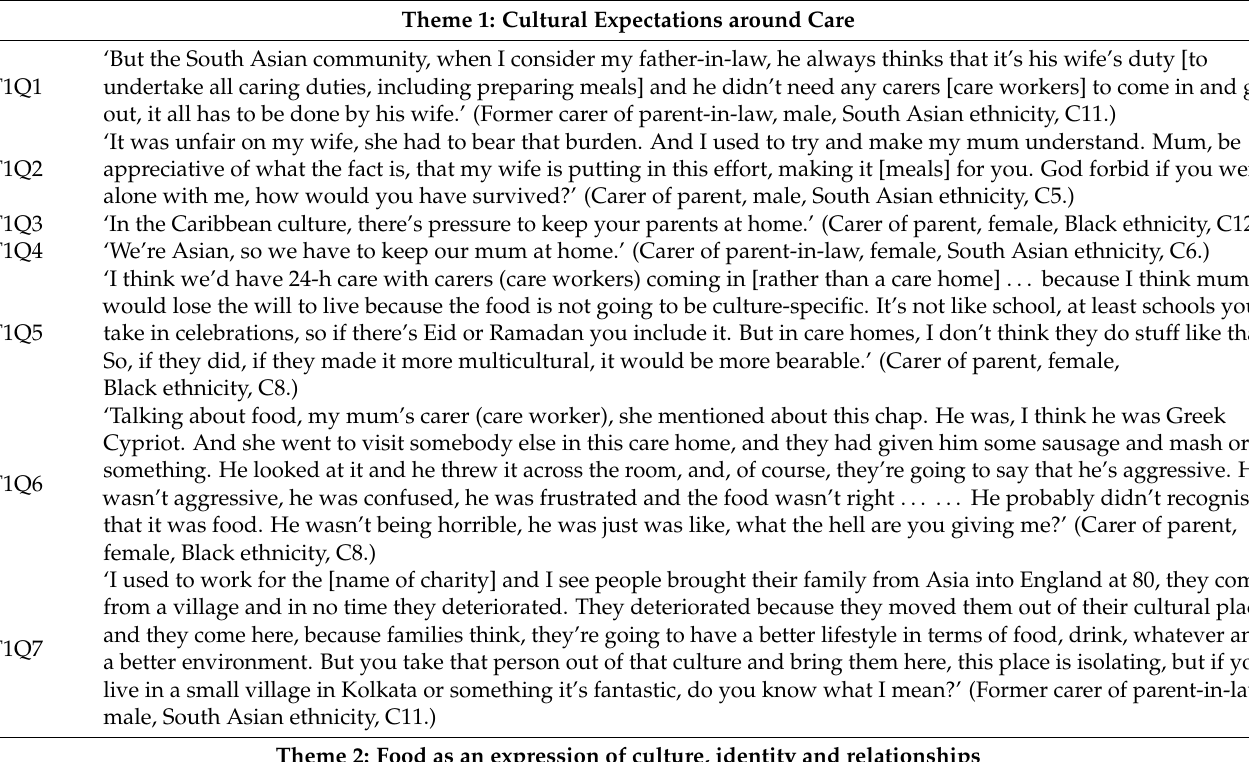
Table 3. Illustrative Quotes for